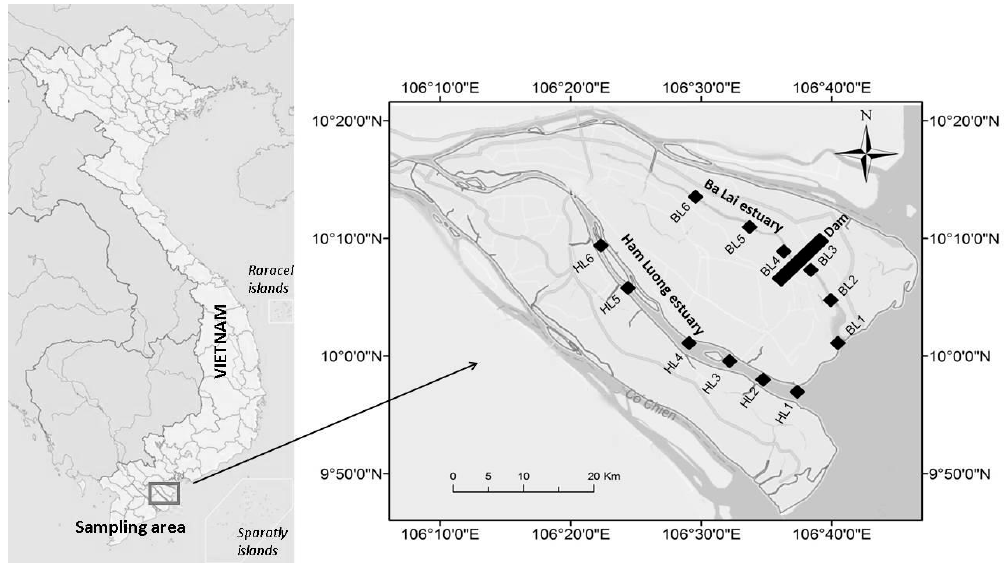
Figure 1. Sampling locations in the Ba Lai and Ham Luong estuary, Ben Tre province, Vietnam.